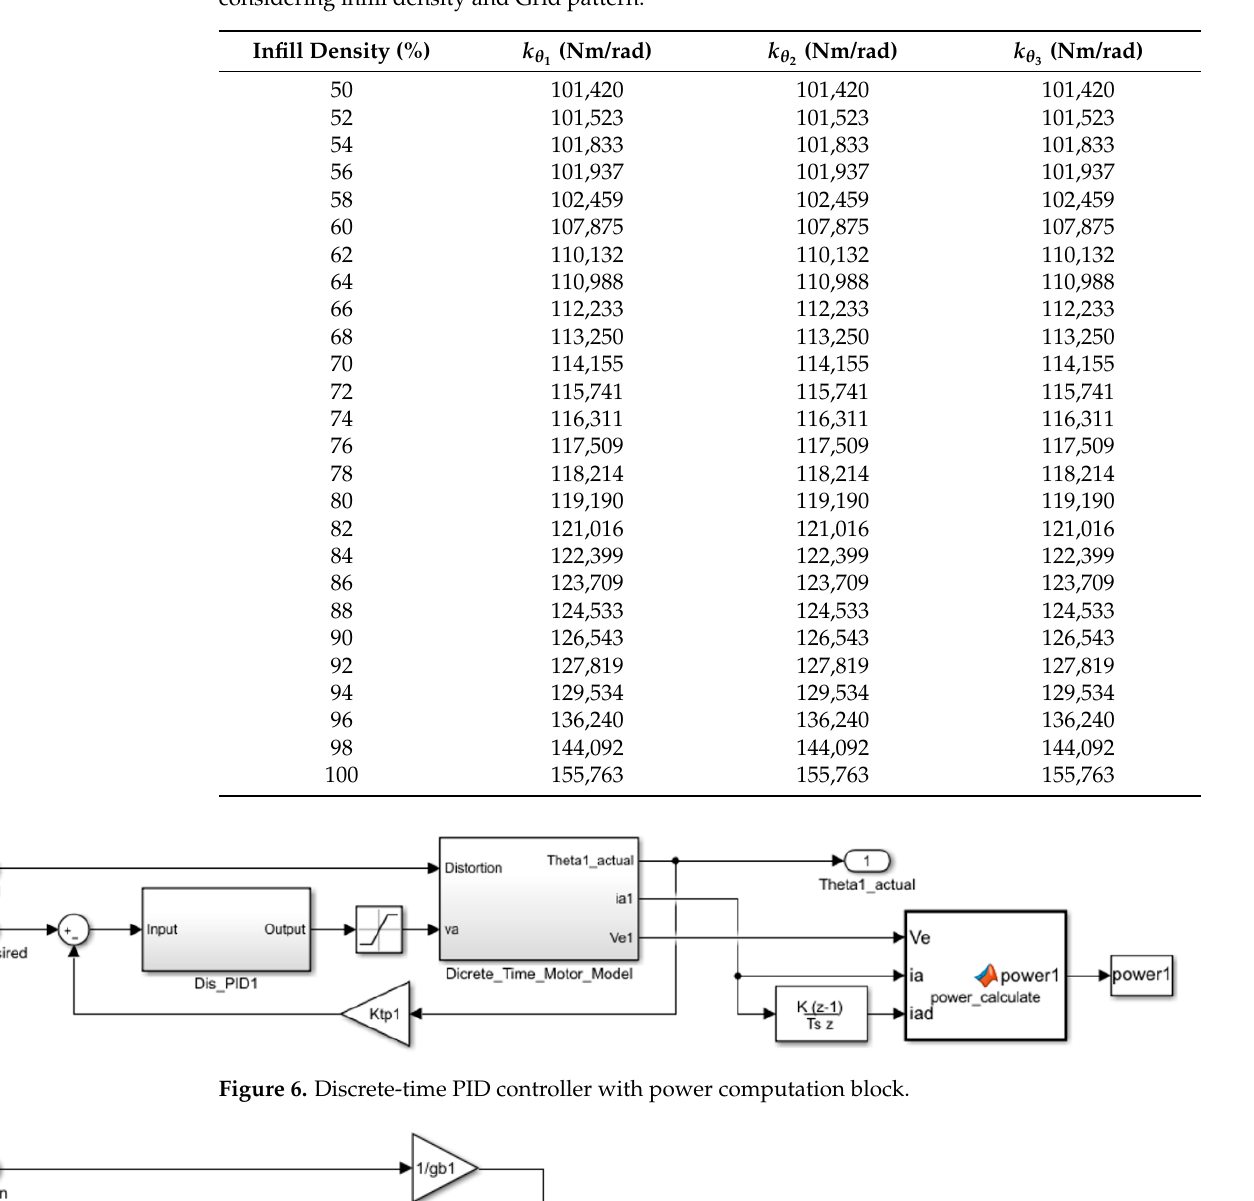
Table 4. Stiffness coefficients of masses obtained from Cura software (version:4.11.0) program considering infill density and Grid pattern.